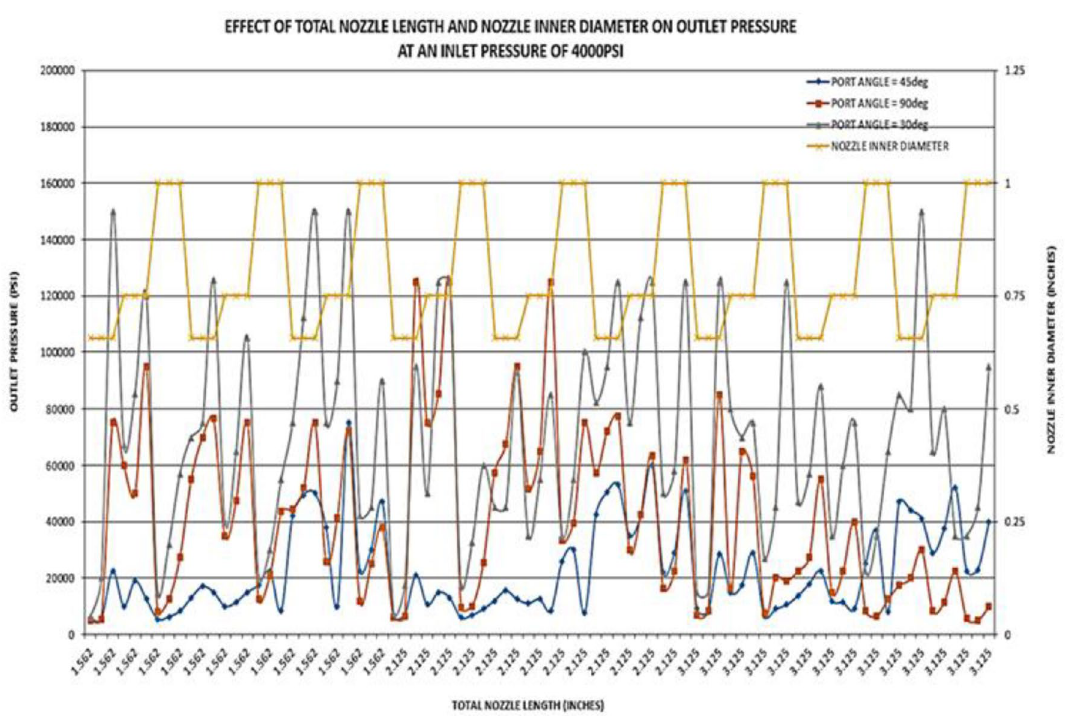
Fig. 11 Effect of total nozzle length and nozzle inner diameter on outlet pressure at an inlet pressure of 4000 PSI